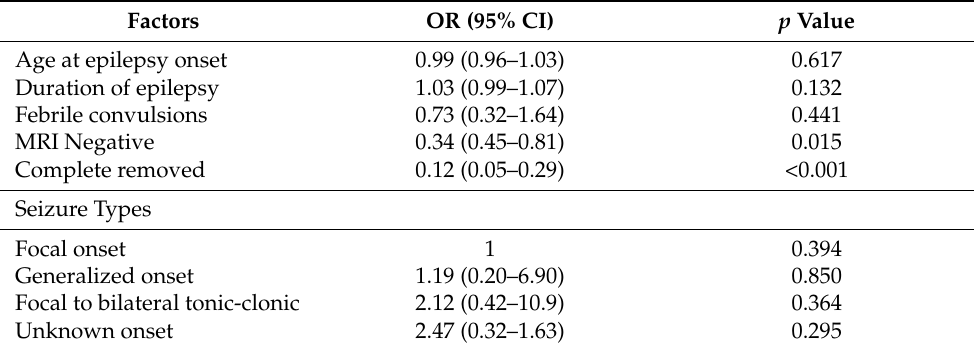
Figure 3. Typical imaging manifestations of FCD type Ⅲ . ( a – d ):GG; Figure ( e – h ): DNET; ( i – l ): PGNT; ( k – l ): AG. The above low-grade developmental epilepsy related tumors were mostly found in the temporal lobe, adjacent to the cortex, and dominated by cystic components. ( m ): CCM, typical “popcorn” change. ( n ): AVM, particulate hypointensity in the proximal cortex; ( o , p ): HS, characterized by hippocampal atrophy and increased signal intensity. Table 3. Logistic regression analysis of risk factors for